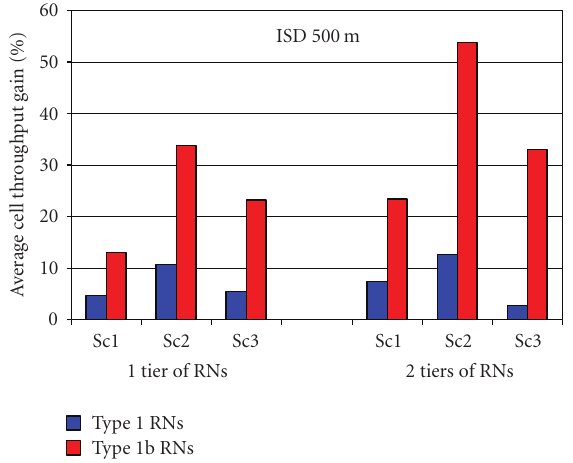
Figure 6: Average cell throughput gains in RN deployments, ISD 500